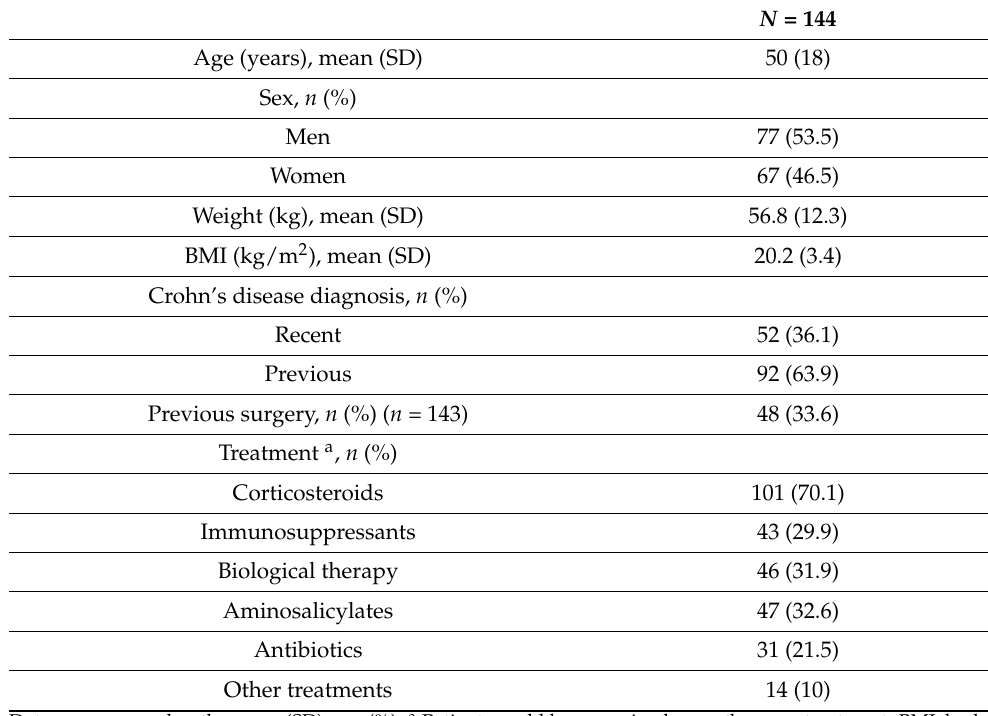
Table 1. Clinical and demographic characteristics of study